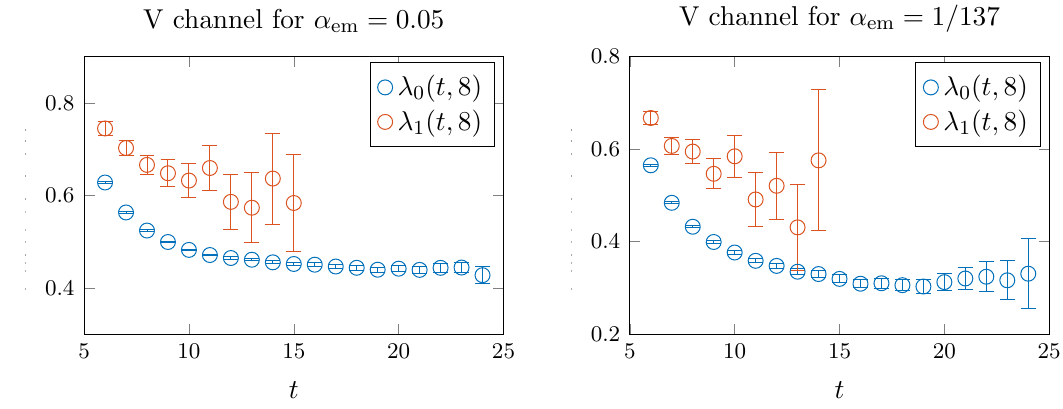
Figure 3 . Effective masses for the ground state, λ 0 ( t, 8) (blue points), and the excited state, λ 1 ( t, 8) (orange points), eigenvalues obtained by solving eq. (4.13) for both the string and Coulomb operators and by averaging the corresponding results. The left plot corresponds to α em = 0 . 05 while the right plot to α em = 1 /